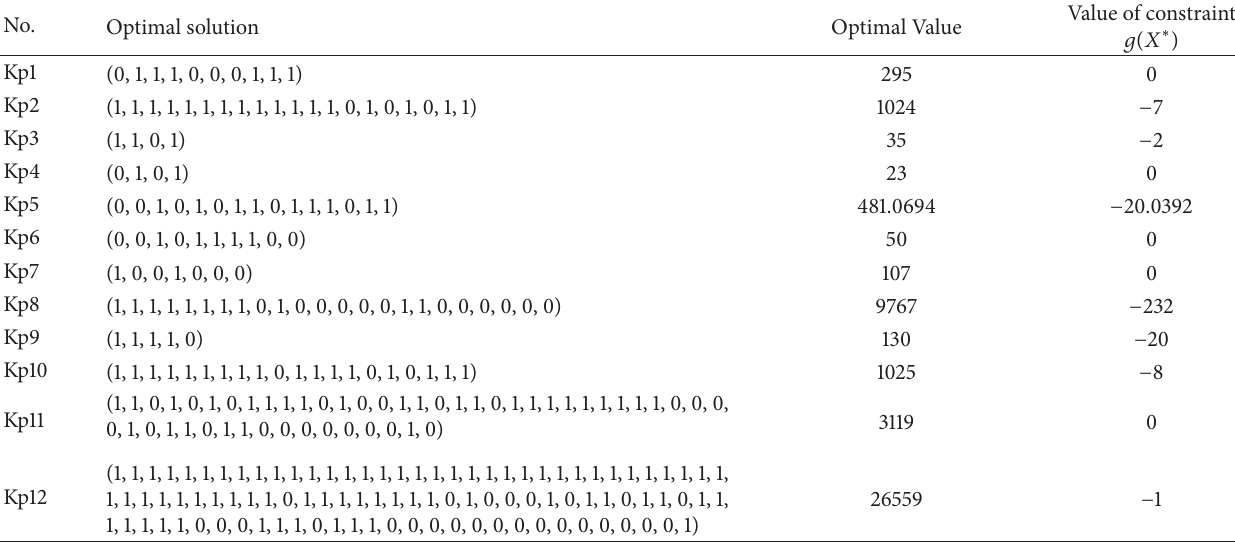
Table 2: The detailed information of the optimal solutions obtained so far on the twelve test problems. No. Optimal solution